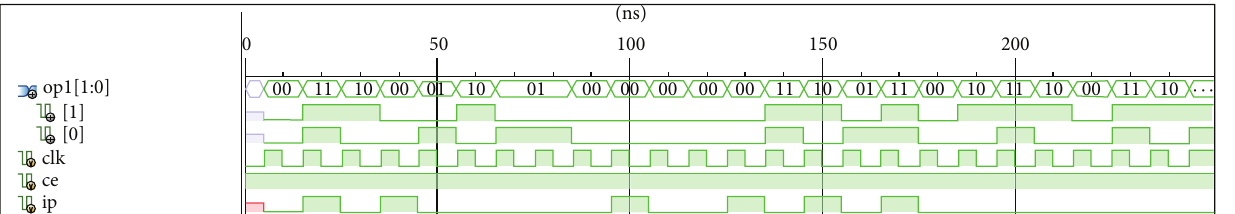
Figure 7: Functional verification of the proposed architecture in ModelSim cosimulation environment.